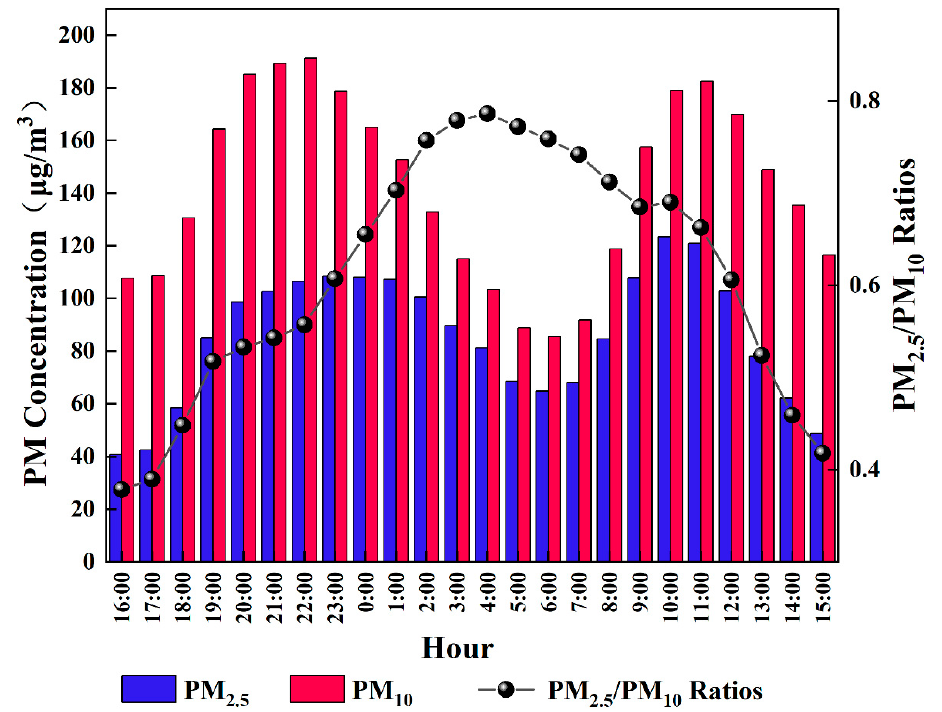
Figure 7. Daily changes in the PM 2.5 /PM 10 ratio and PM concentration at urban sites from September 2017 to February 2019.